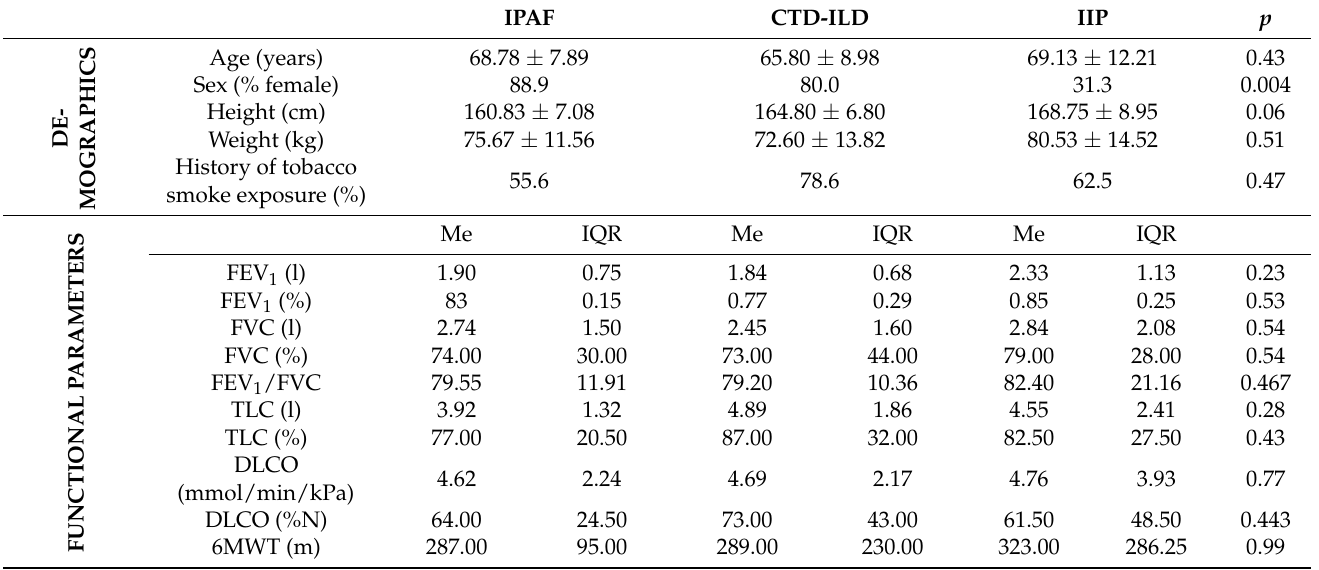
Figure 3. NSIP in course of IPAF. Table 1. Study group